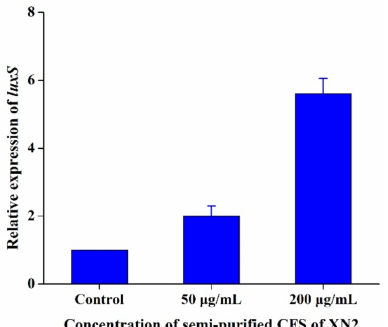
Figure 6. Effect of semi-purified CFS of strain XN2 on the relative expression of luxS of S. aureus . The data are shown as mean ± standard deviation. The critical limit is 5%. p < 0.05, the differences are